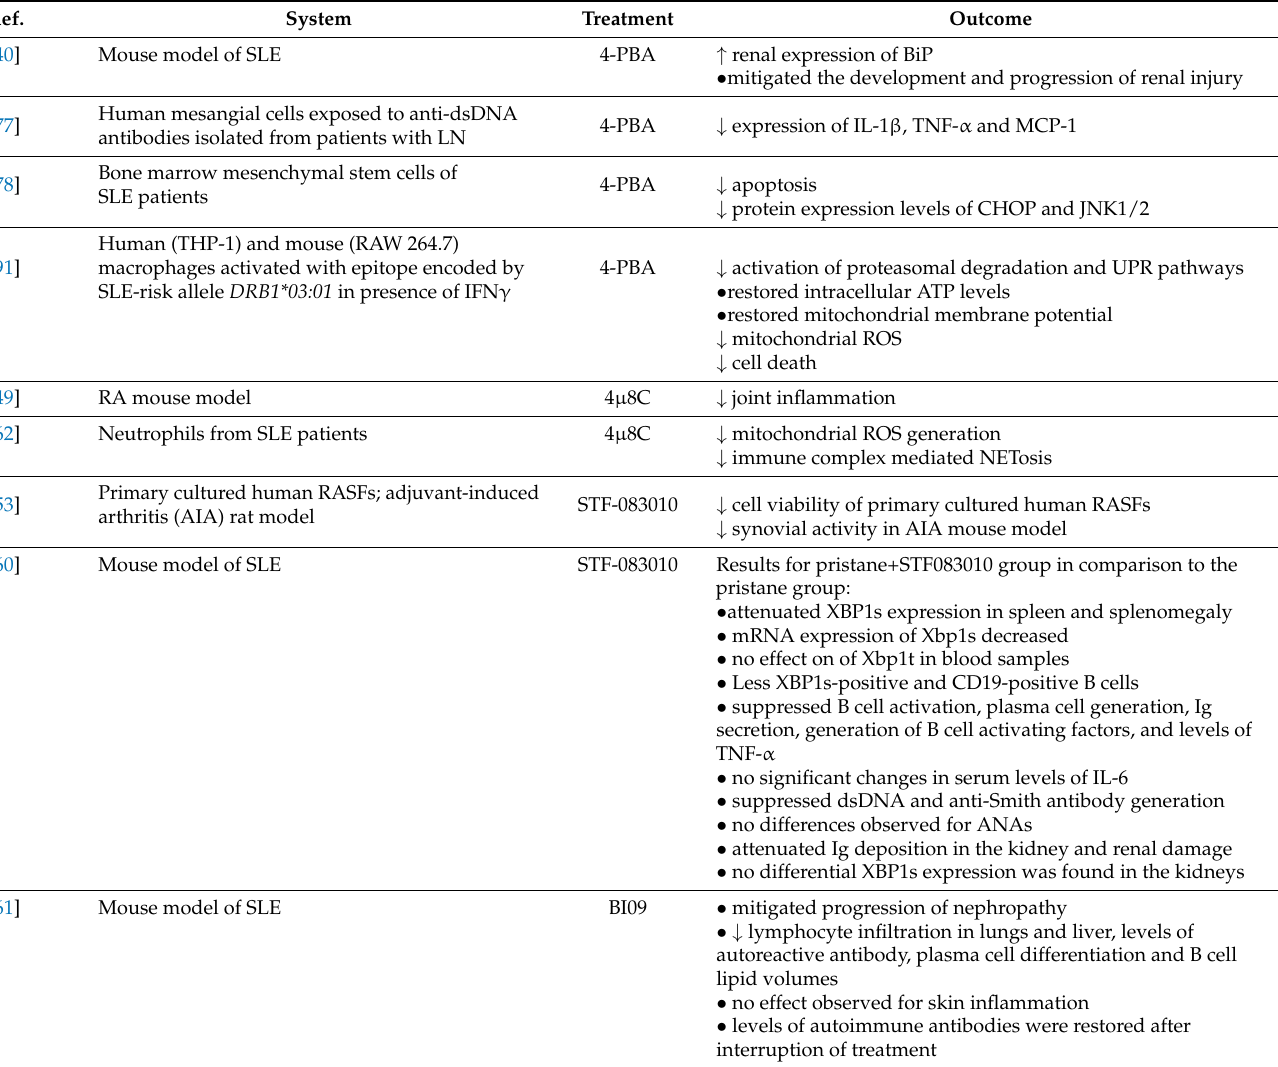
Table 1. Summary of studies targeting endoplasmic reticulum stress in rheumatoid arthritis and systemic lupus